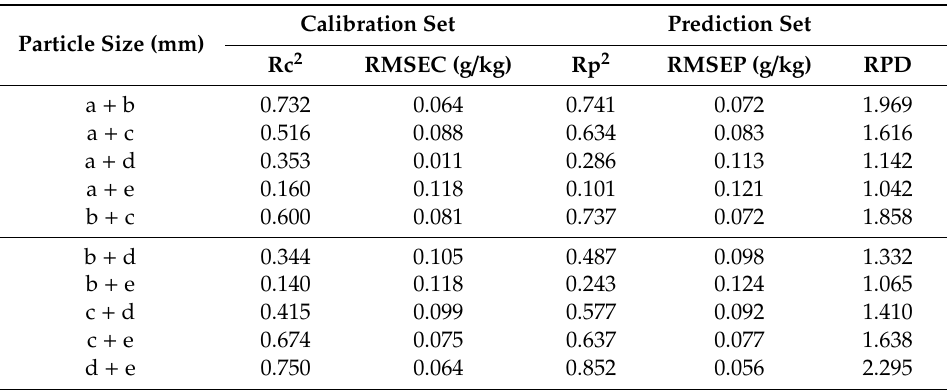
Table 2. The PLS model prediction of di ff erent soil particle